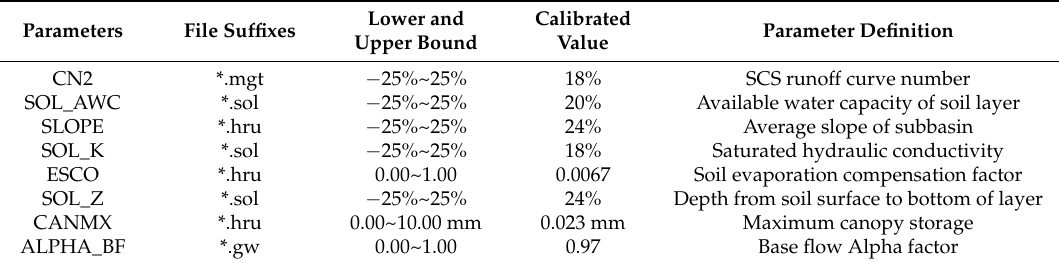
Table 3. Results of parameter calibration.